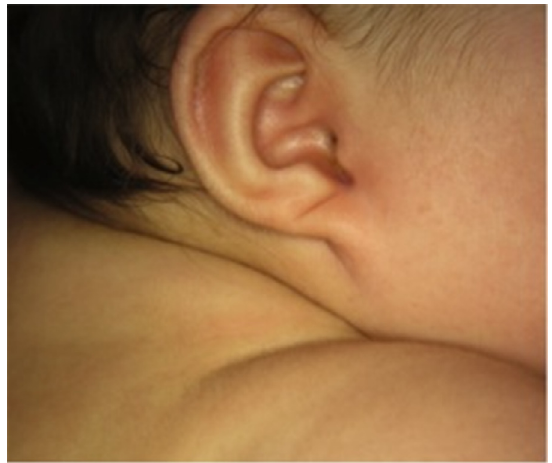
Fig. 2. Ear anomaly with marked notch on